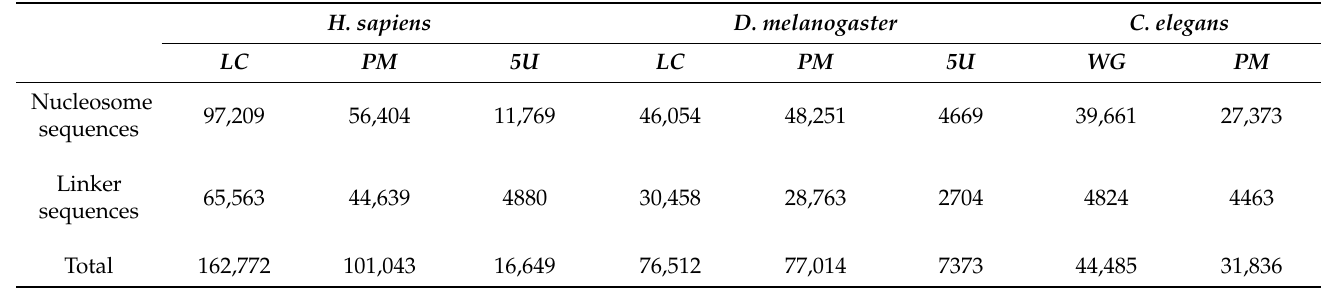
Table 2. The number of positive samples and negative samples in the DatasetNup_2 . H. sapiens